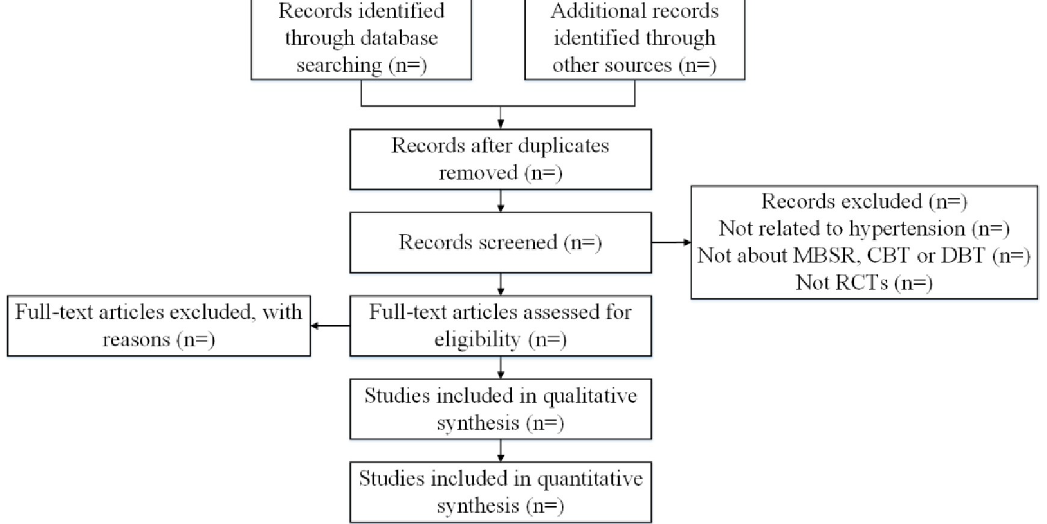
Fig 1. Preferred reporting items for systematic review and Bayesian network